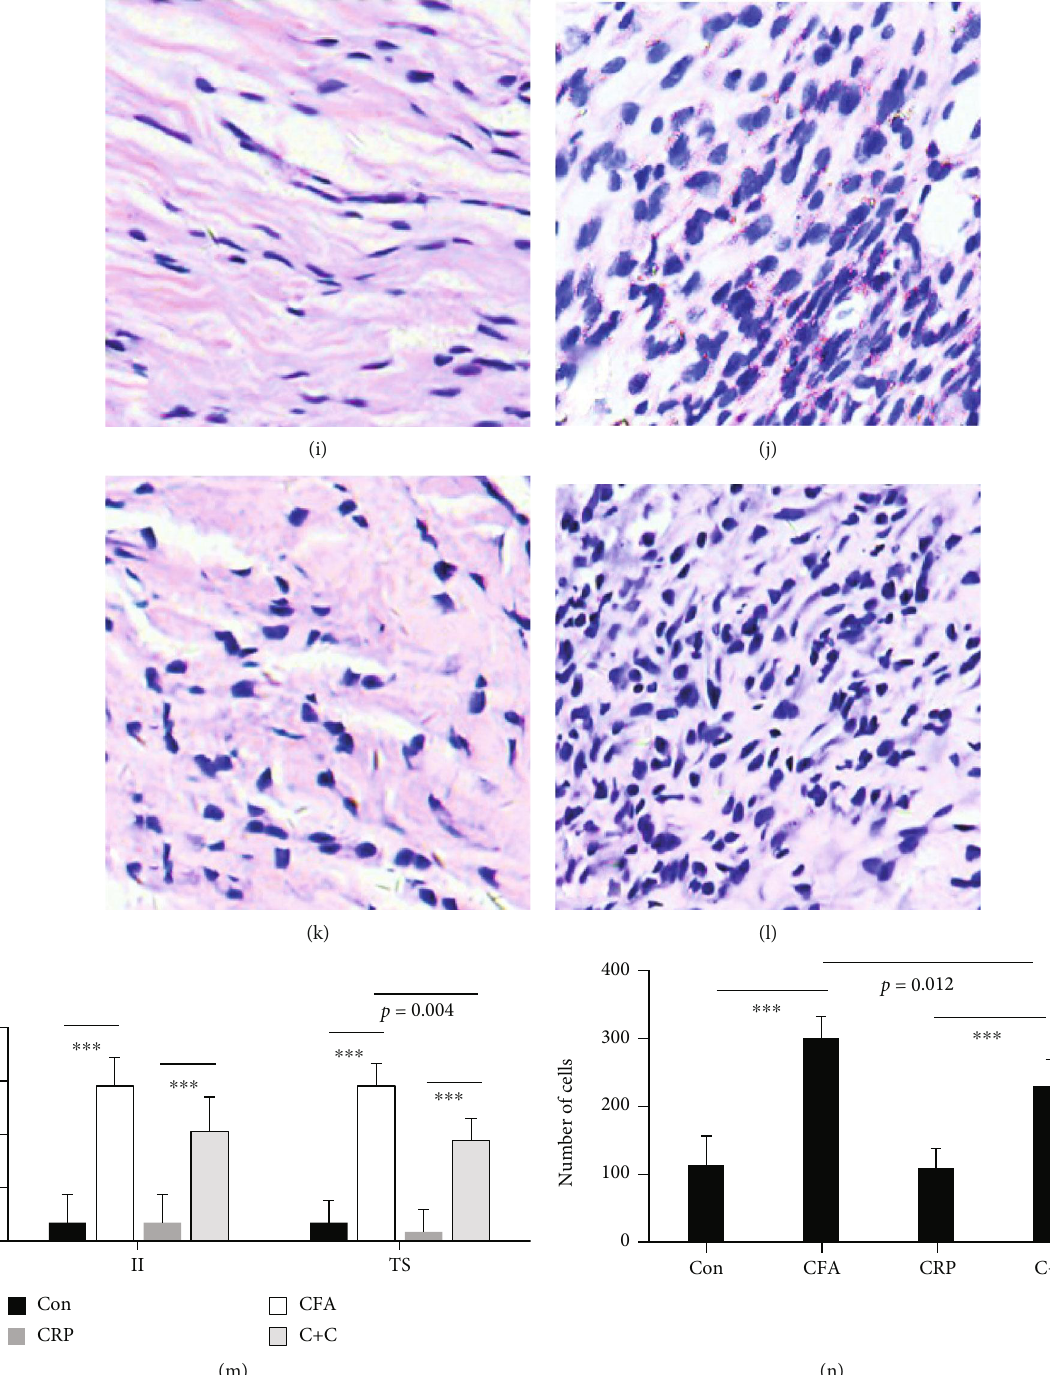
Figure 5: Histological changes in the synovial membrane. (a) – (d) Representative images of H&E-stained slides showing synovial membranes of the anterior superior region from Con, CFA, CRP, and C + C groups, respectively. (e) – (h) Representative images of synovial membranes of the posterior superior region from Con, CFA, CRP, and C + C groups, respectively. The orange box indicates a 100 × 100 μ m square used for counting in fi ltrating in fl ammatory cells. (i) – (l) Magni fi ed images of areas in orange boxes from (e) – (h). (m) In fl ammatory score based on in fl ammatory cell in fi ltrate (II) and thickening of the synovial membrane (TS). (n) Number of mononucleated cells in a 100 × 100 μ m square of the synovial membrane measured to determine in fl ammatory in fi ltration. ( N = 6 ; mean + SD ; ∗∗∗ p < 0 : 001